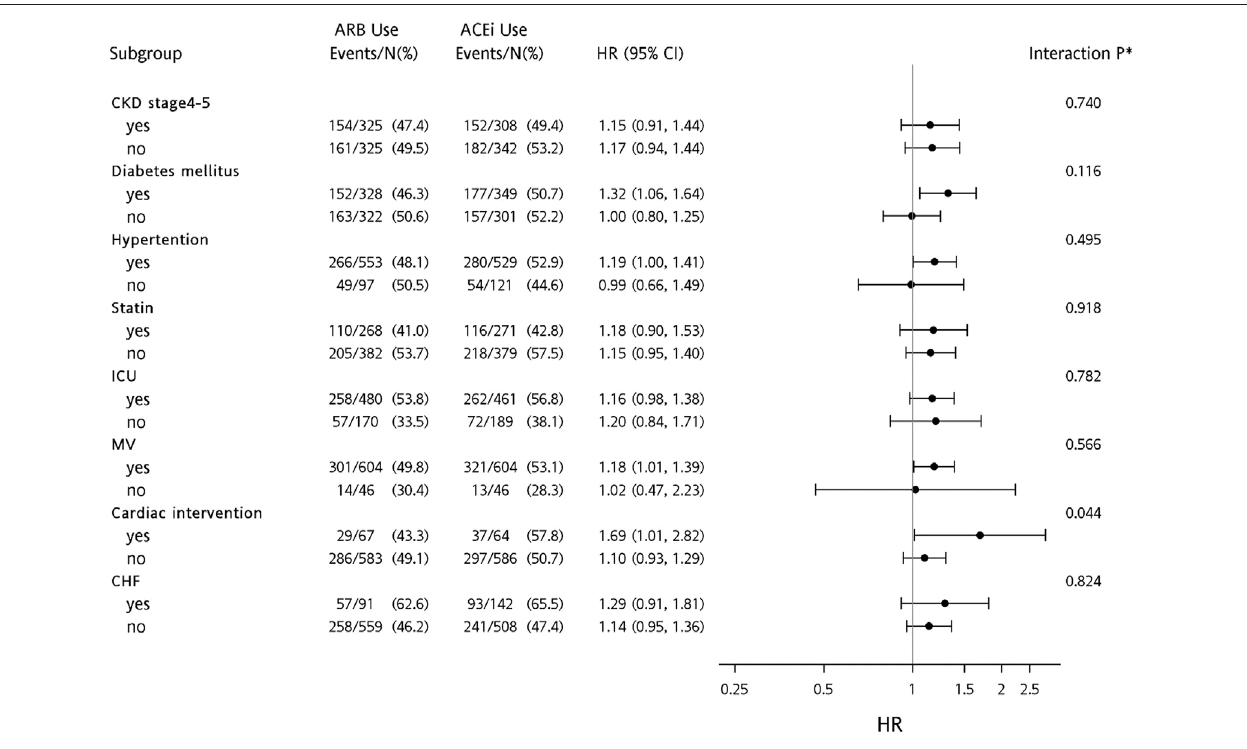
FIGURE 4 | Forest plot comparing risk levels of all-cause mortality for before-dialysis ACEi and ARB users.